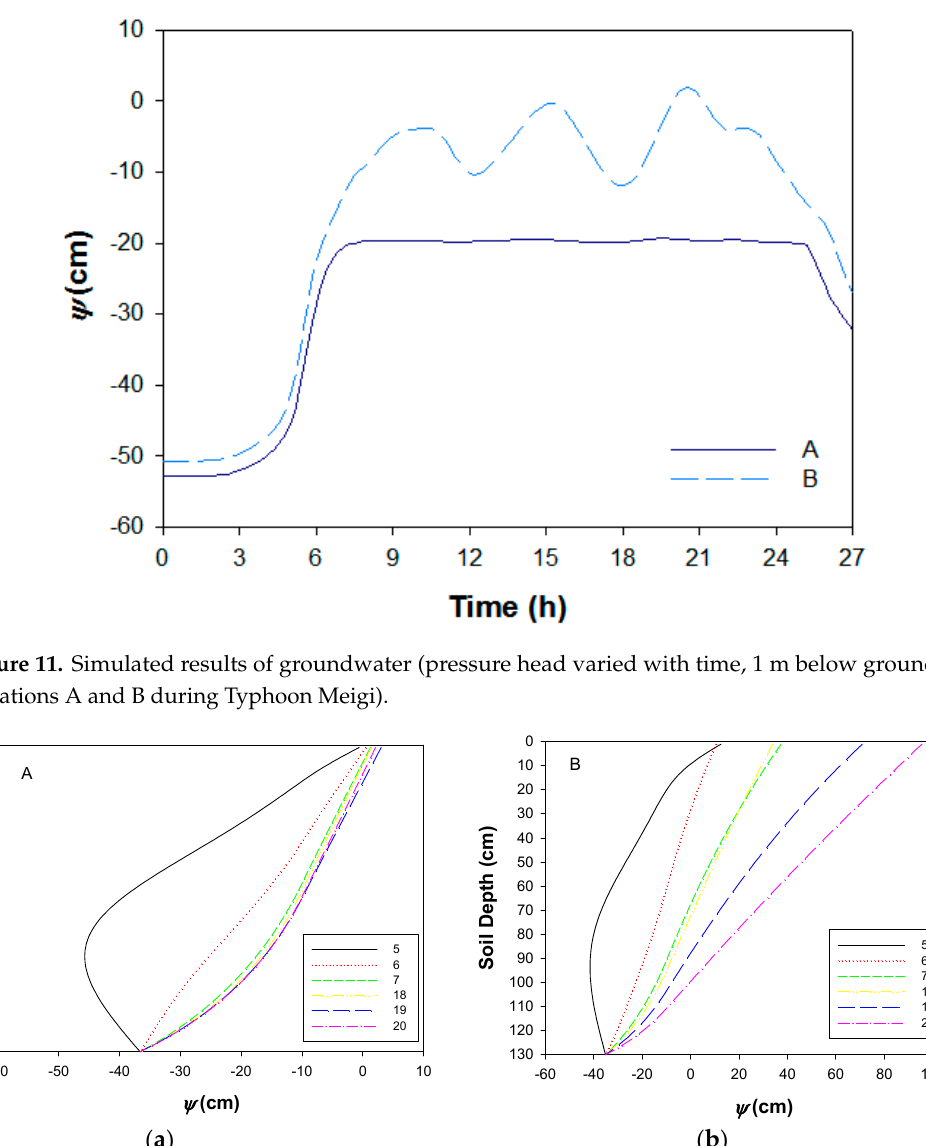
Figure 12. Simulated results of groundwater pressure heads at ( a ) Location A and ( b ) Location B.